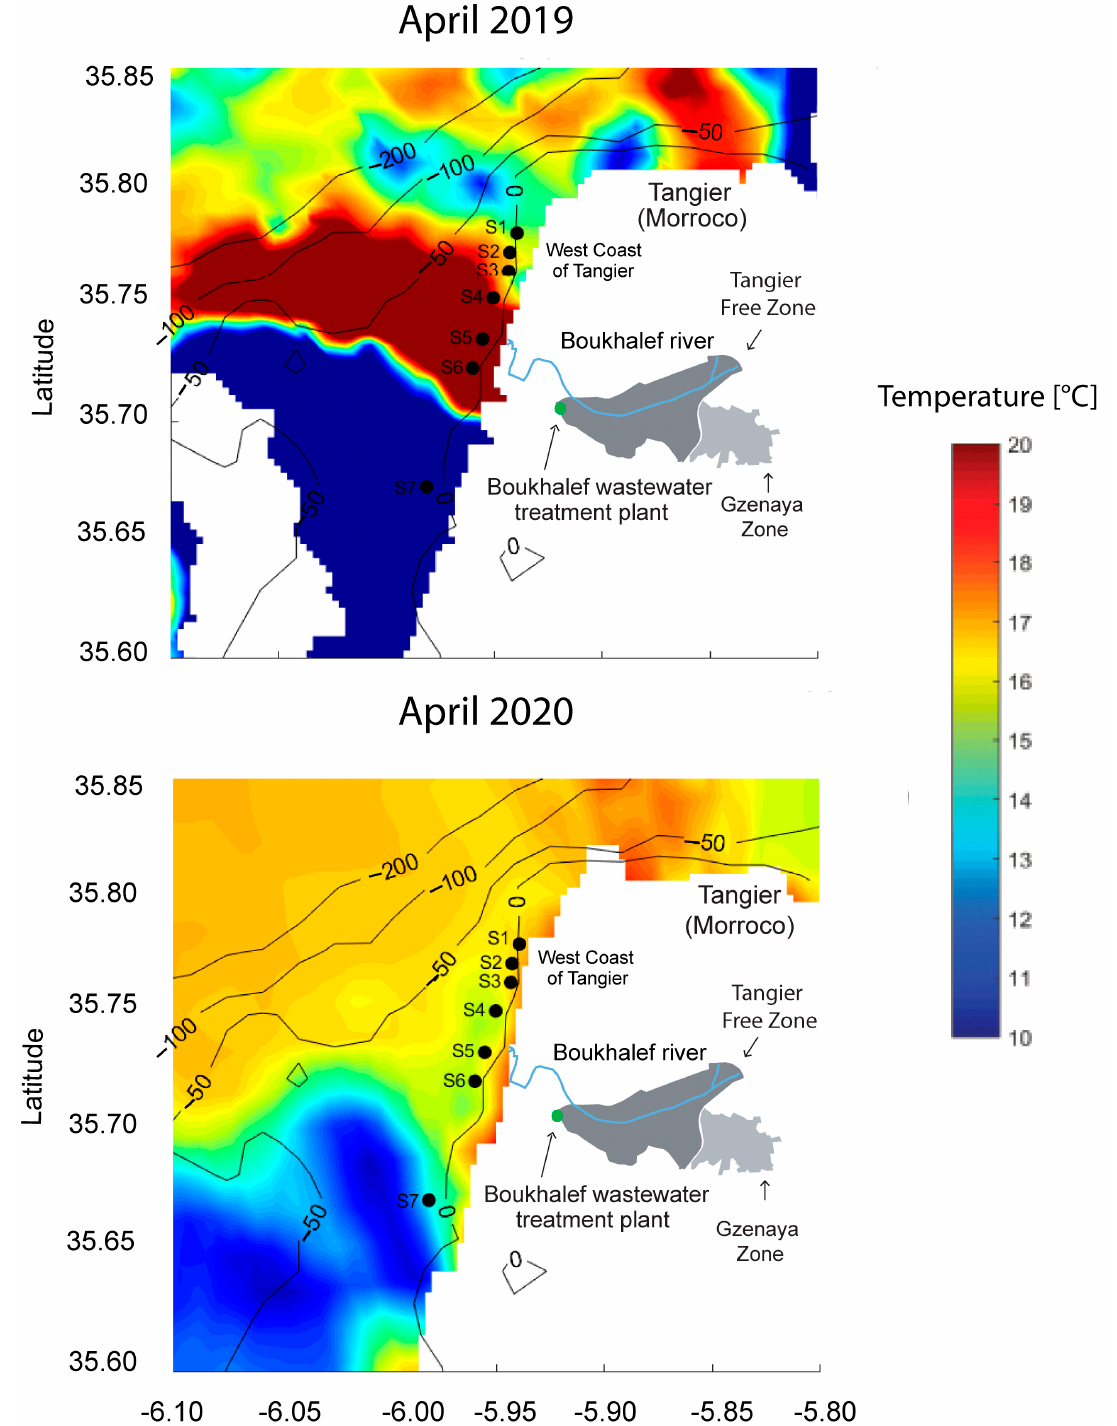
Figure 6. Observations of water surface temperature (°C) on the west coast of Tangier, northern Morocco, April 2019 and 2020.